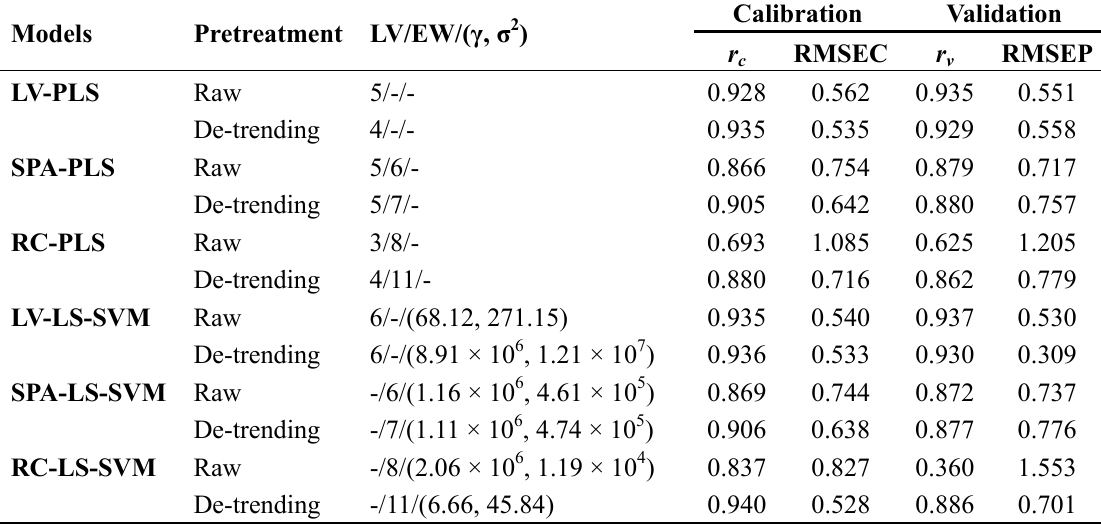
Table 4. The prediction results of total amino acid (TAA) content in barley leaves by different